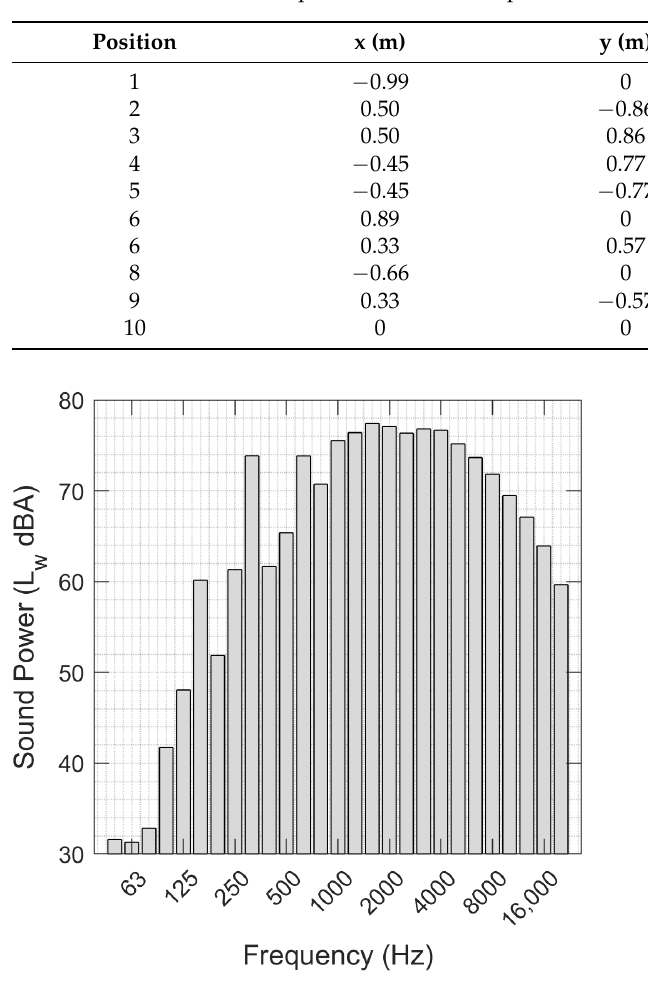
Table 1. ISO 3744:2010 Microphone measurement positions.